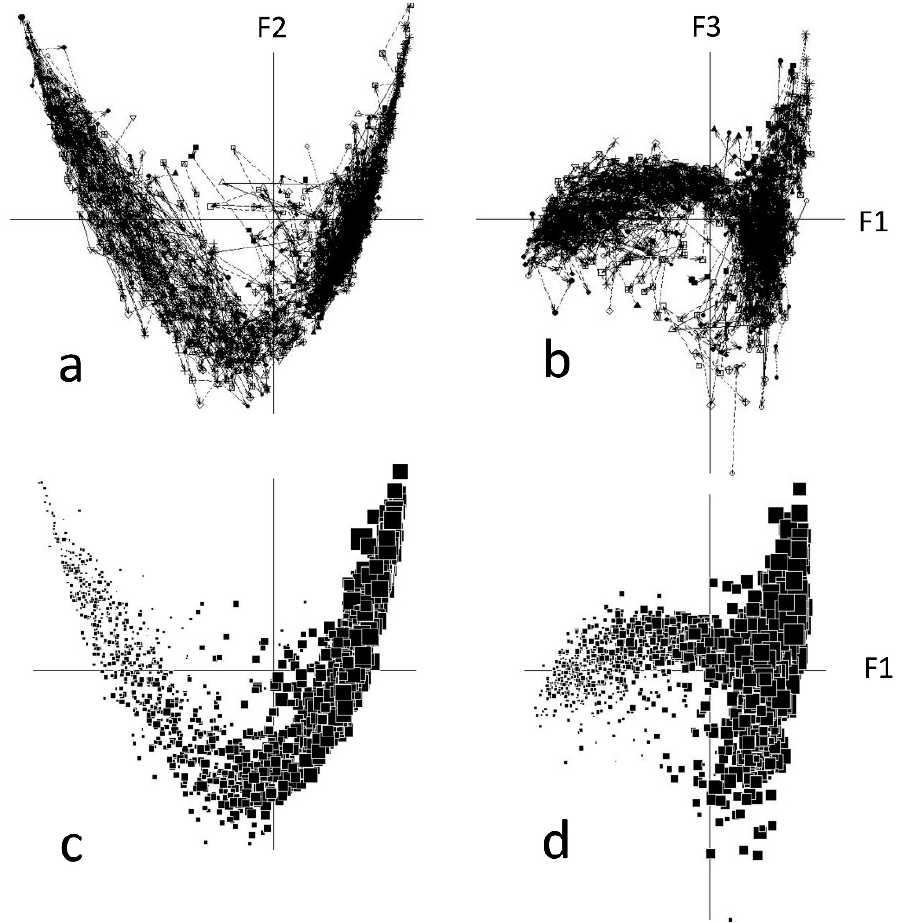
Figure 5. ( a , b ). Envelope of the 154 postfire trajectories (including repeated fires on a same station) of the sampling stations on the two first planes of the correspondence analysis of the bird matrix (F1–F2 and F1–F3, respectively); ( c , d ) Indices of foliage volume in the corresponding samples.